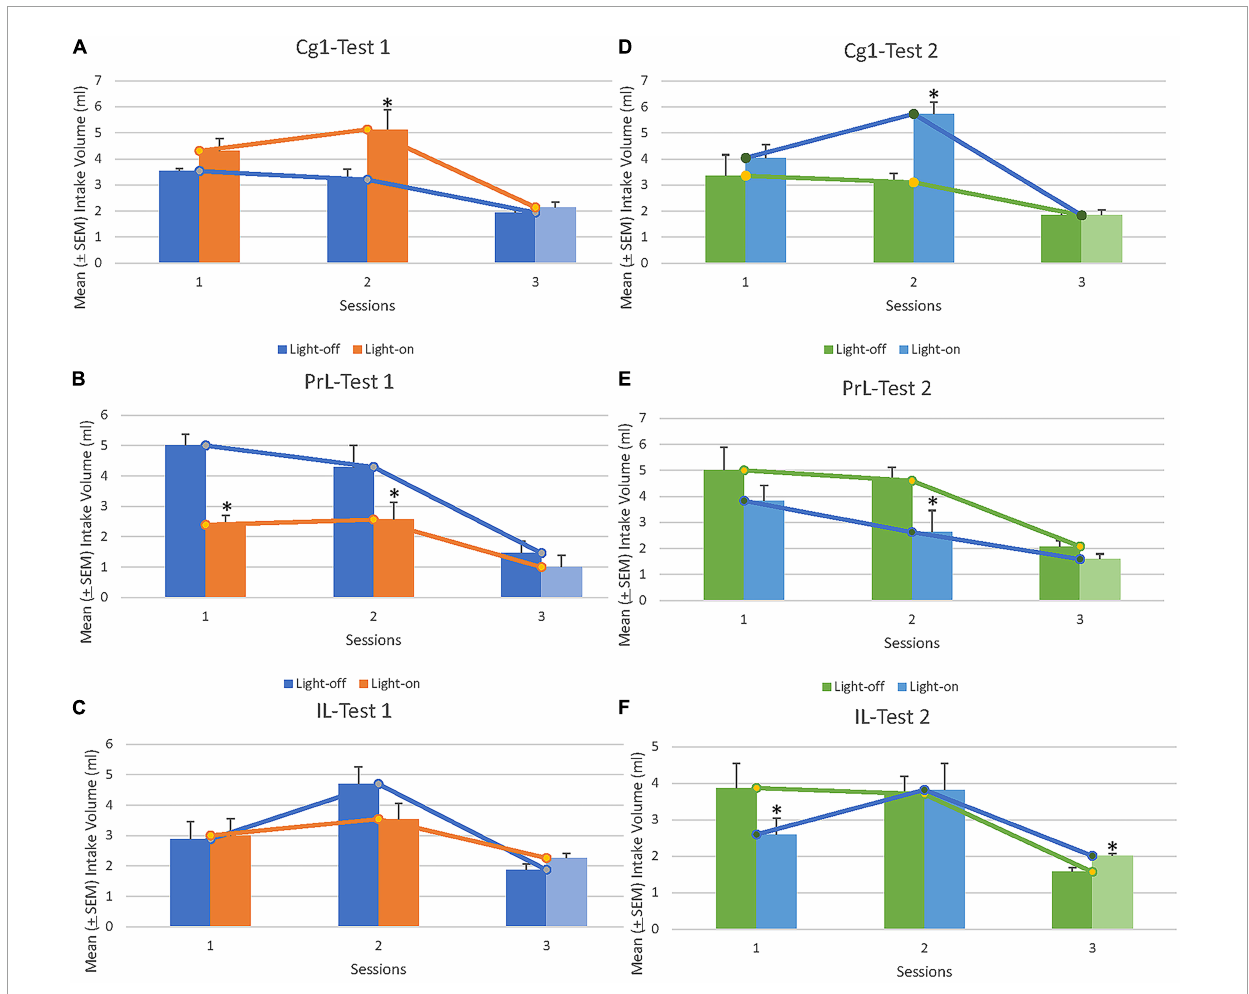
FIGURE3 Mean ( ± SEM) intake volume of saccharin solution in rats in light-on and light-off conditions following optical stimulation of Cg1, PrL, and IL for Sessions 1 and 2, Tests 1 (A–C) and 2 (D–F) . In Session 3, the rats drank saccharin solution with the lights off for 12 min. ∗ p < 0.05 indicates a significant difference between the light-on and light-off sessions. Note that, light and dark blue or green vertical bars indicated light-off treatments in Test 1 and Test 2. In summary, the Cg1 increased the rewarding saccharin solution consumption; however, the PrL decreased the rewarding saccharin solution consumption. The IL did not affect the rewarding valence of the saccharin solution consumption.